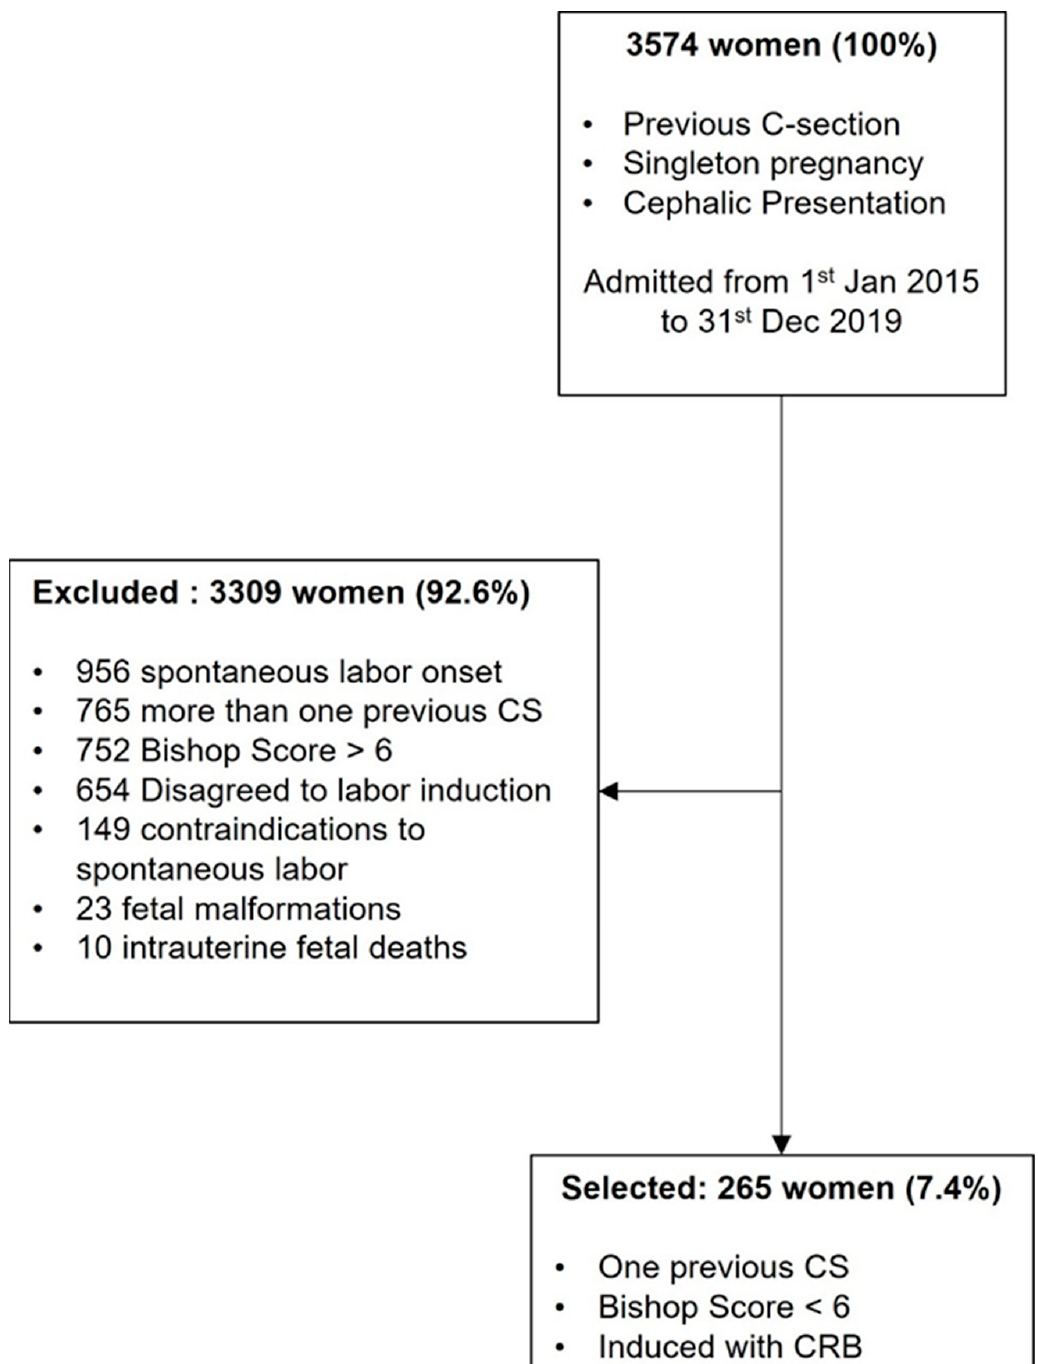
Figure 1. STROBE flow chart. CS: cesarean section.